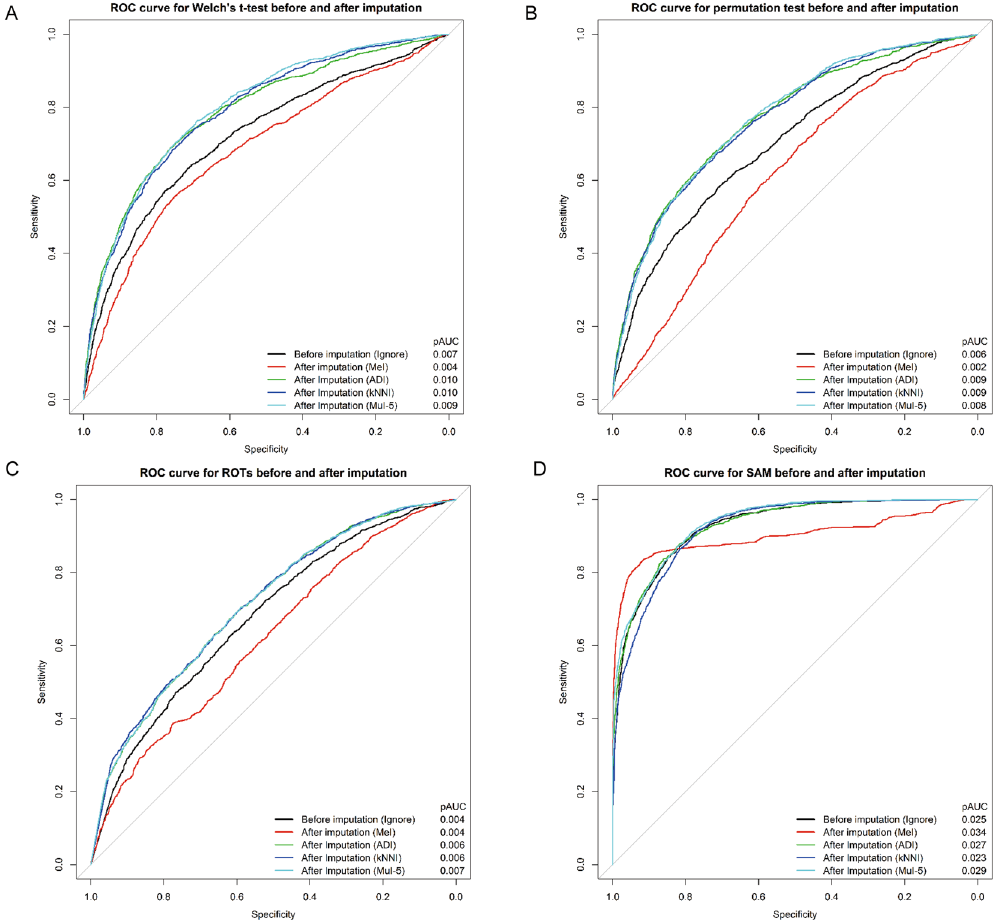
Figure 4. ROC curves for Welch’s t-test ( A ), permutation test ( B ), ROTs ( C ) and SAM ( D ) before and after four different imputation methods in D1. “Ignore” corresponds to the test results not considering the MVs. pAUC values were listed on the right bottom of each panel.